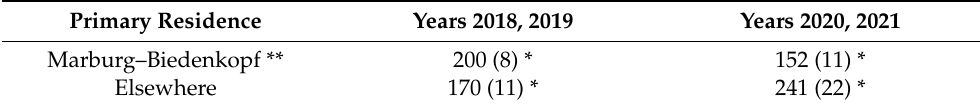
Table 2. Primary residence, year of admission, and mortality in 763 consecutive neurotrauma cases.